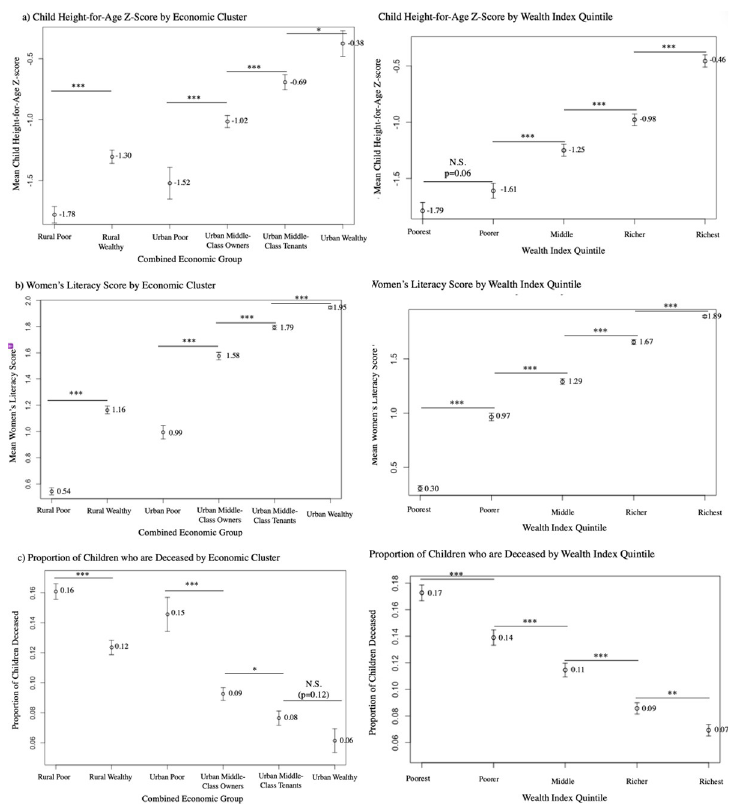
Fig 5. Mean child HAZ, women’s literacy score, and proportion of children who are deceased for combined Cameroonian EconomicClusters and DHS Wealth Index quintiles. Caption: Horizontal bar indicates p-value for two-sample student’s t-tests between adjacent groups: � = p < 0.05, �� = p < 0.01, ��� = p < 0.005 †Literacy Score: 0 = “Cannot read at all”, 1 = “Able to read only parts of a sentence”, 2 = “Able to read whole sentence” Error Bars: Standard error of the